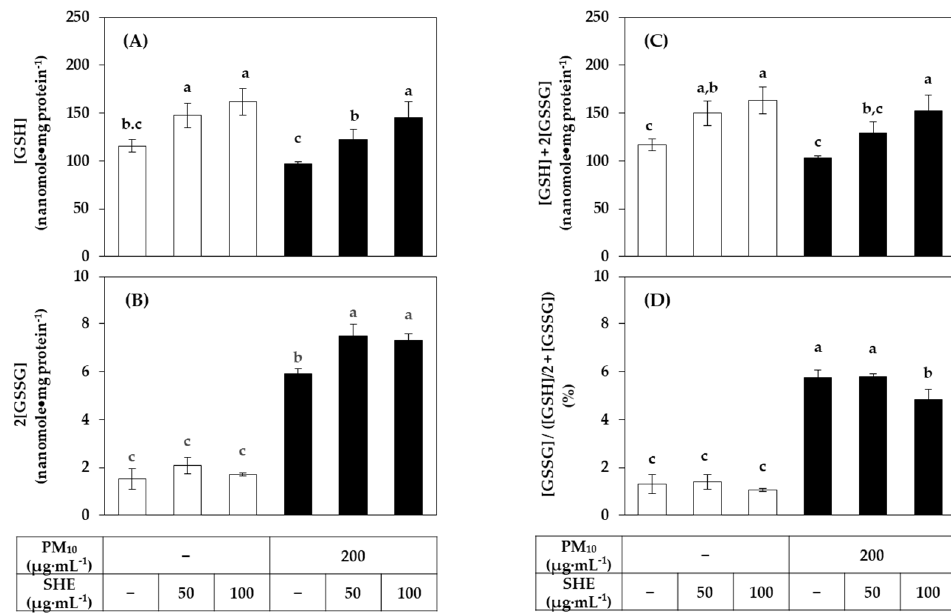
Figure 7. Effects of SHE on the contents of reduced glutathione (GSH) and its oxidized form, gluta- thione disulfide (GSSG) in HaCaT keratinocytes exposed to PM 10 . Cells were treated with SHE at different concentrations and cultured in the absence or presence of PM 10 (200 μ g mL − 1 ) for 24 h. The